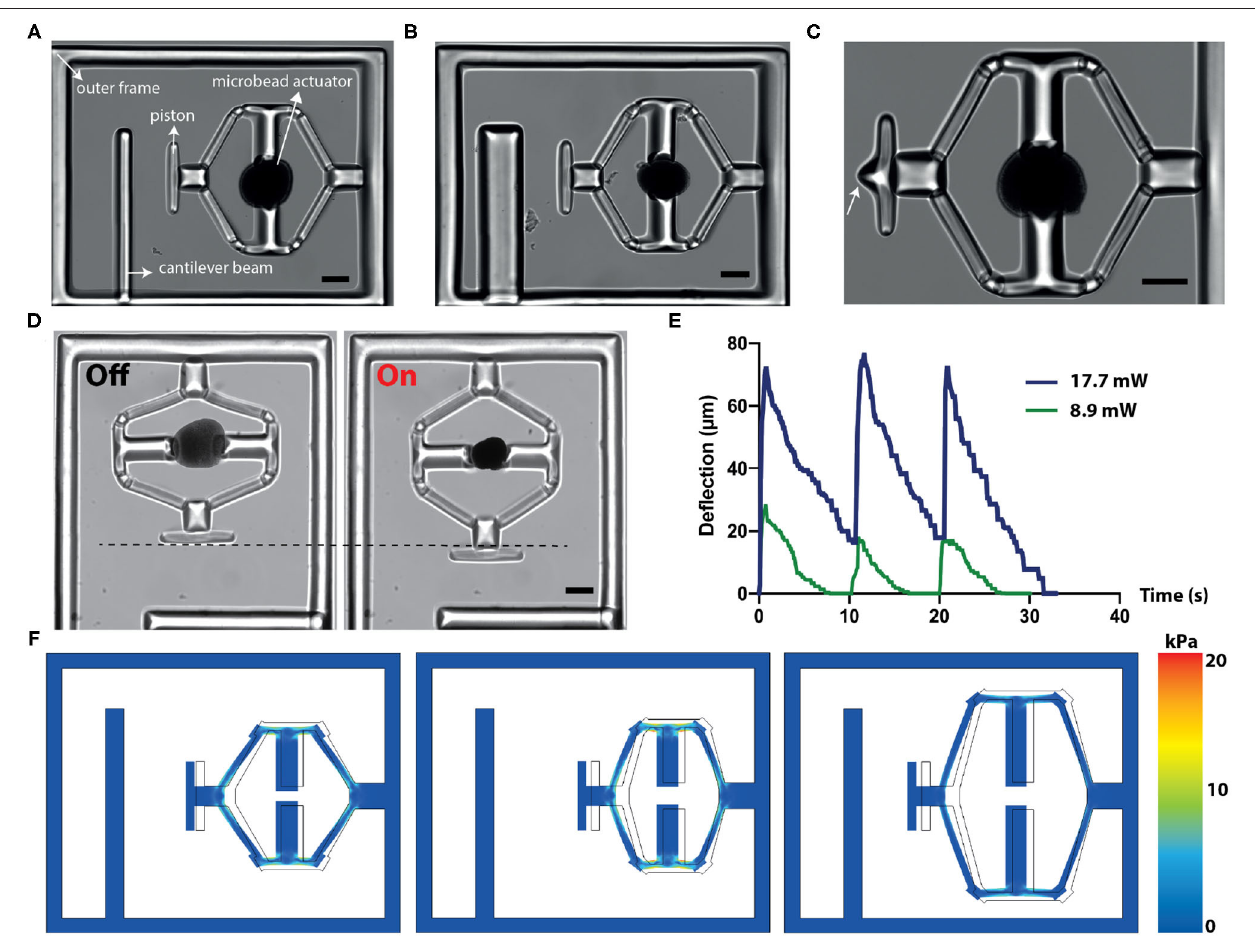
FIGURE 2 | Design, operation, and computational analysis of the compressors. (A) A bright-field microscope image of the device showing different modules. (B) The cantilever beam geometry can be modified to tune the the sensitivity of the sensor. (C) The design of the piston can be modified to tune the applied stress. White arrow points to the sharp tip engineered for localized indentation. (D) Temporal sequence of micrographs from a representative actuation cycle. (E) The displacement vs. time plot for the piston at different NIR laser power. The signal duration is 500 ms and the actuation frequency is 0.1 Hz. (F) Simulation results for different flextensional mechanism designs. The arm angle and length can be modified to tune the piston displacement and stress on the mechanism. Scale bars, 100 µ